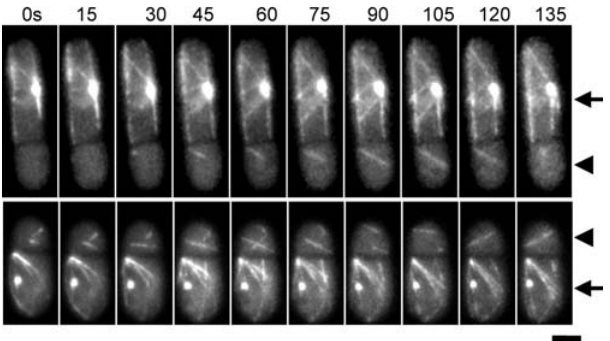
Figure 3. Dynamic cytoplasmic microtubules are present in anucleate compartments. Shown are two time-lapse montages of cdc16 -116 Pcp1p-GFP cells expressing GFP-Atb2p ( a -tubulin). The larger nucleate cells, indicated by arrows, have multiple robust and dynamic microtubule bundles. In contrast, the smaller anucleate cells, indicated by arrowheads, have fewer, yet dynamic microtubules. Scale, 5 m m.